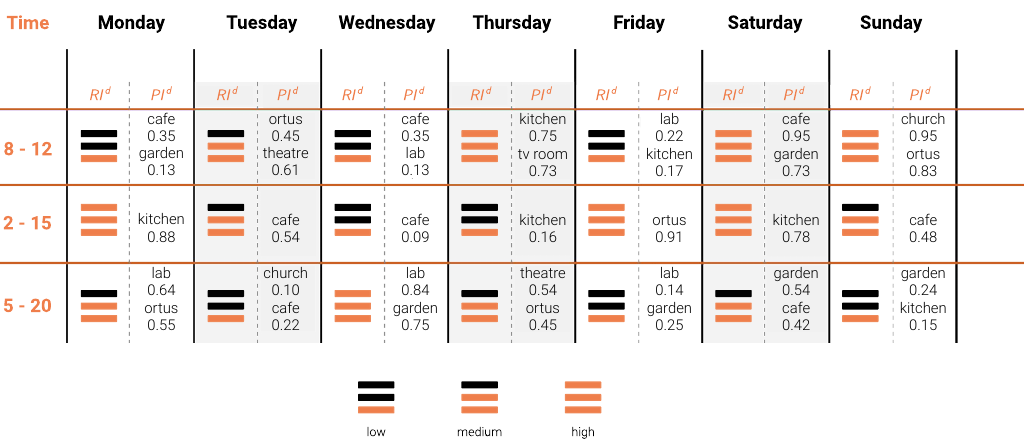
Figure 5. Community behaviour Prediction